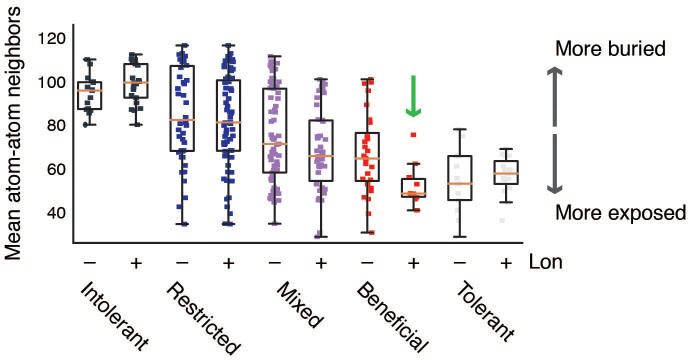
Burial of residues within each mutation response category reported as the mean number of atomic neighbors.Each point represents one amino acid side chain, and the y-axis reports the average number of heavy atom neighbors within an 8 Å shell for all heavy atoms in that side chain. Box plots are overlaid on the distribution to show the median (orange bar) and upper/lower quartiles. Mutational response categories are shown for both –Lon and +Lon selection. The green arrow highlights the absence of buried Beneficial positions in +Lon selection.